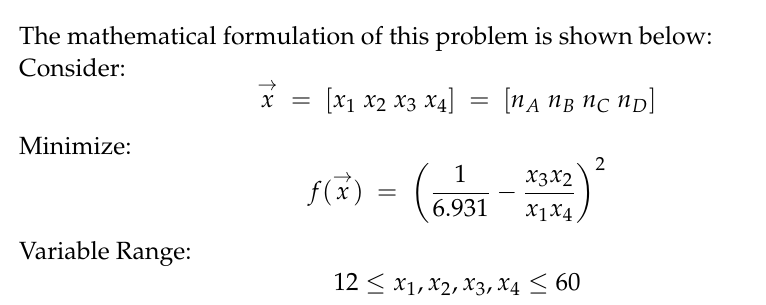
Figure 13. Gear train design